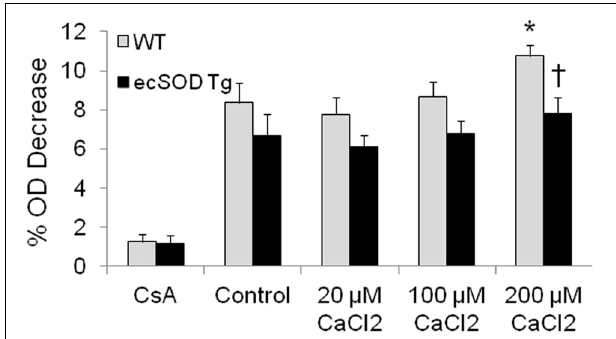
FIGURE 3 | Mitochondrial ecSOD contributes to mitochondrial permeability transition. Mitochondria isolated from WT and ecSOD Tg hearts were incubated with control (0 µ M Ca 2 + ), 20, 100, and 200 µ M Ca 2 + to trigger MPT. MPT was measured as the percent decrease in optical density (OD) at 592nm due to mitochondrial swelling. Mitochondrial swelling was increased with increasing Ca 2 + . Cyclosporine A (10 µ M), which stabilizes mitochondrial permeability transition pore, blocked Ca 2 + -mediated swelling. Values are the mean ± SEM of 3 experiments. * p < 0 . 05 vs. Control (WT or Tg), † p < 0 . 05 vs.